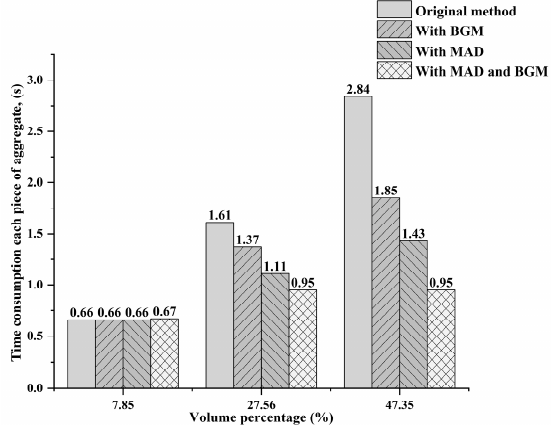
Figure 14. Time consumption for placing each piece of aggregate.